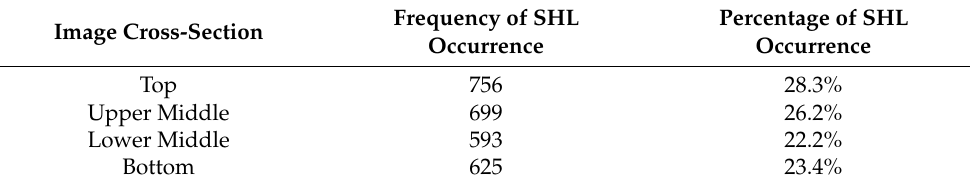
Table 6. Presence of sea horizon line in equally distributed cross-sections of images.